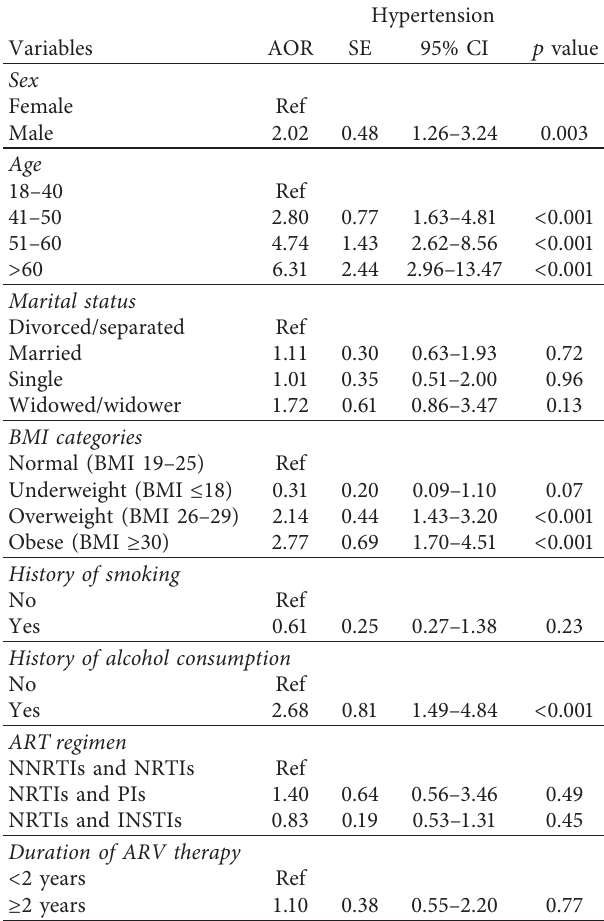
associated with hypertension among HIV